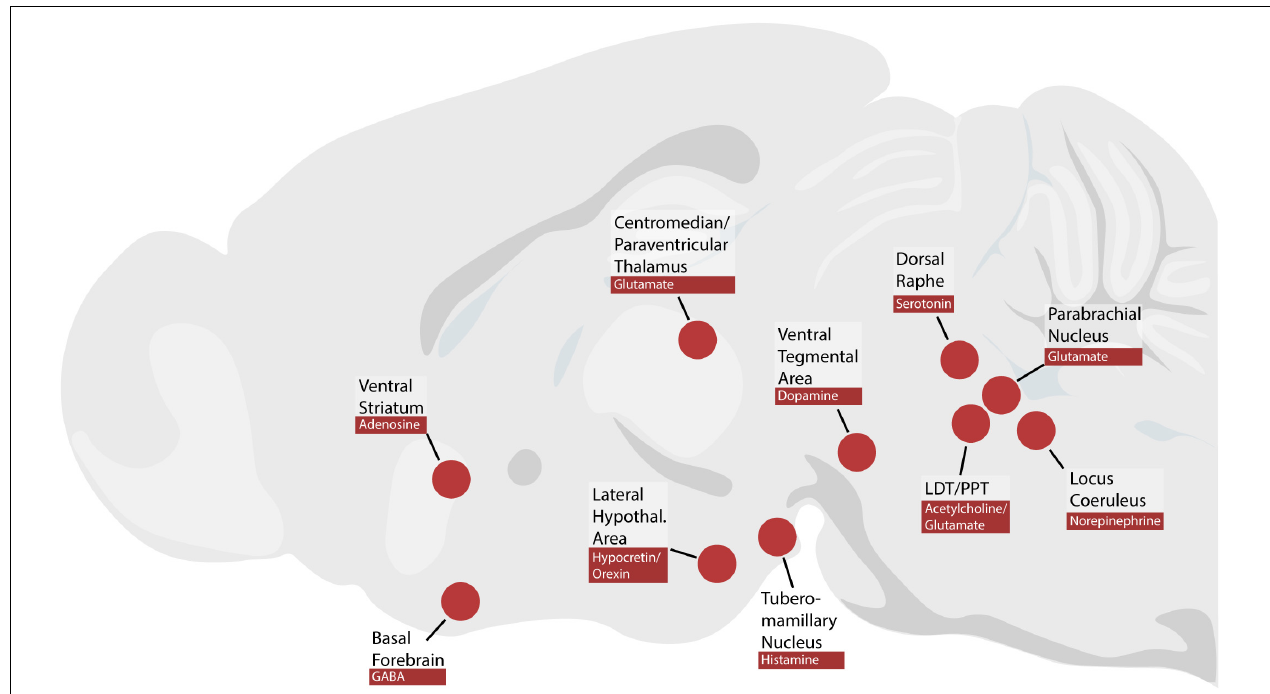
FIGURE 2 | Brain regions and neuromodulators discussed in this review. PPT, pedunculopontine tegmental nucleus; LDT, laterodorsal tegmental nucleus.